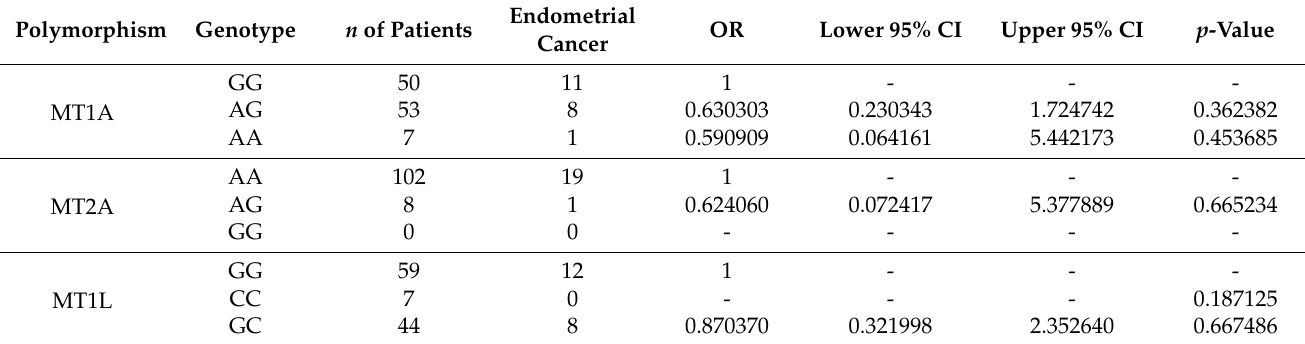
Table 3. Univariate logistic regression model.